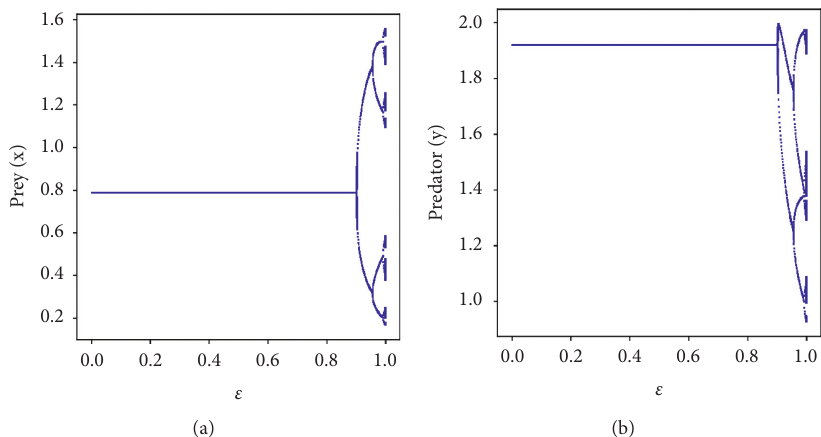
Figure 9: The bifurcation diagrams for the controlled system (54) with r E ∗ ( x ∗ ,y ∗ ) � ( 0 . 787379 , 1 . 922151 ) , and ϵ ∈ ( 0 , 1 ] .